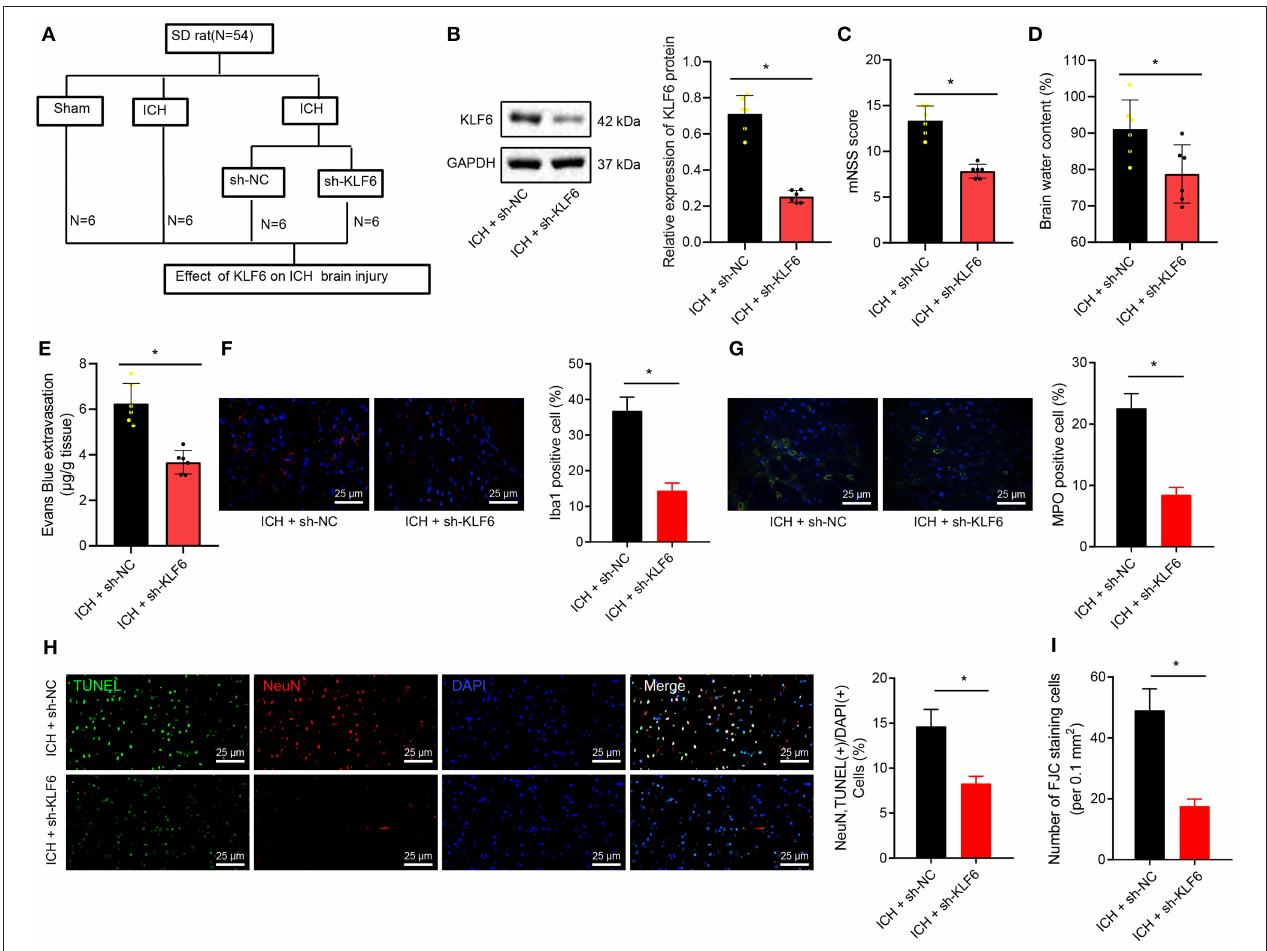
FIGURE 3 | KLF6 silencing attenuates neurological dysfunction and hippocampal neuronal apoptosis and degeneration in ICH rats. (A) Establishment of ICH model with KLF6 silencing ( n = 6). (B) The level of KLF6 in the hippocampal tissues of three paired ICH rats 72h after modeling and infection with sh-KLF6. (C) The mNSS score of ICH rats 72h after modeling and infection with sh-KLF6. (D) The cerebral water content changes in brain tissues of ICH rats 72h after modeling and infection with sh-KLF6. (E) Evans blue permeation in brain tissues of ICH rats 72h after modeling and infection with sh-KLF6. (F) The activation of microglia in ICH rats 72h after modeling and infection with sh-KLF6 (Iba1 + cells was quantified). (G) The activation of neutrophils in ICH rats 72h after modeling and infection with sh-KLF6 (MPO + cells were quantified). (H) The apoptosis of hippocampal neurons in ICH rats 72h after modeling and infection with sh-KLF6 (NeuN + TUNEL + cells was quantified). (I) The quantitative analysis of degeneration of hippocampal neurons in ICH rats 72h after modeling and infection with sh-KLF6 as detected by FJC staining. n = 6 rats/group * p < 0.05 compared with ICH rats infected with sh-NC. The measurement data were expressed as mean ± standard deviation. Comparisons between two groups were analyzed using unpaired t -test, and comparisons among multiple groups were tested by one-way ANOVA followed by Dunnett post-hoc